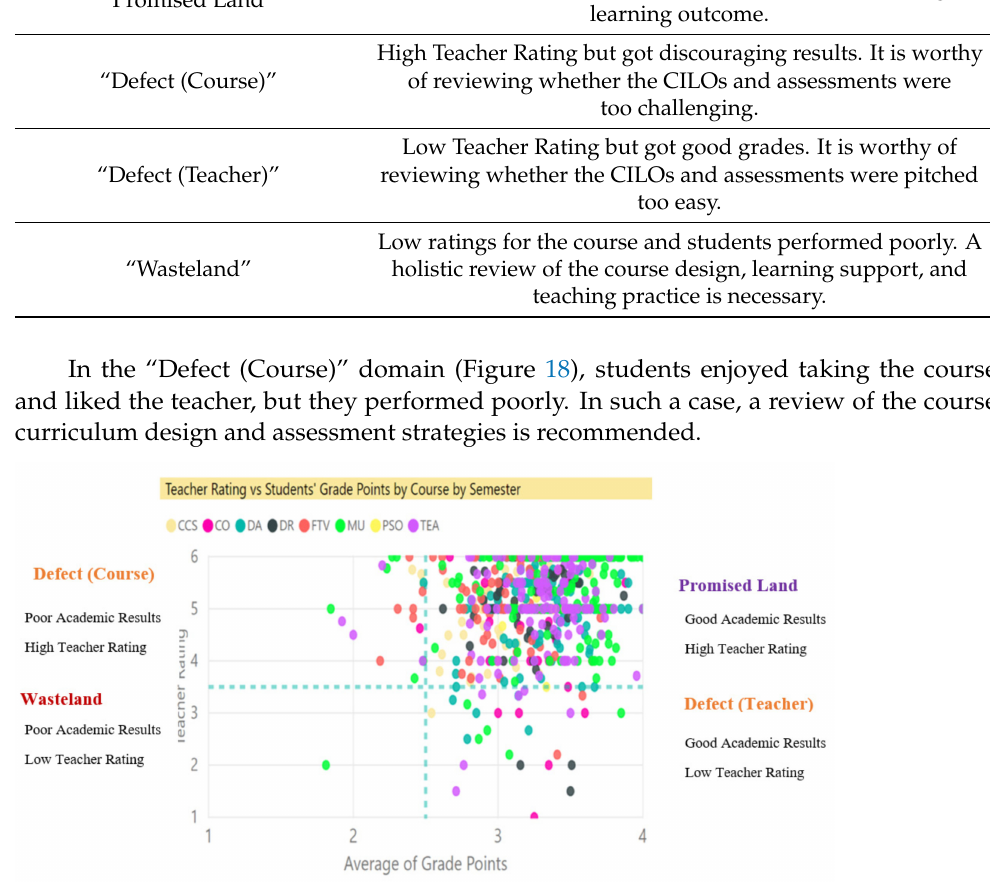
Figure 18. Average Grade Points–Teacher Rating Matrix. Note: (1) In the visual, each data point represents the average Teacher Rating given by students, and students’ grade for a particular